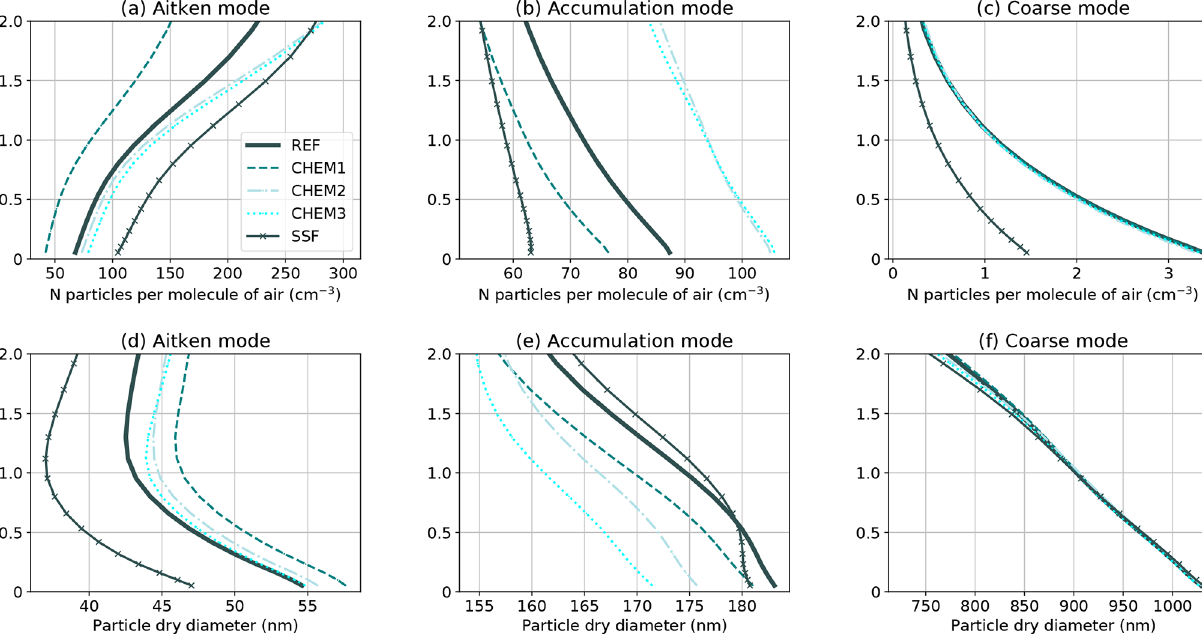
Figure 8. Climatological-mean profiles in DJF between 40 and 60 ◦ S in the lowest 2km of the atmosphere of aerosol mode number concen- tration (a, b, c) and dry diameter (d, e, f) for the REF, CHEM and SSF simulations. Panels (a, d) show the soluble Aitken mode; (b, e) the accumulation mode; (c, f) the coarse